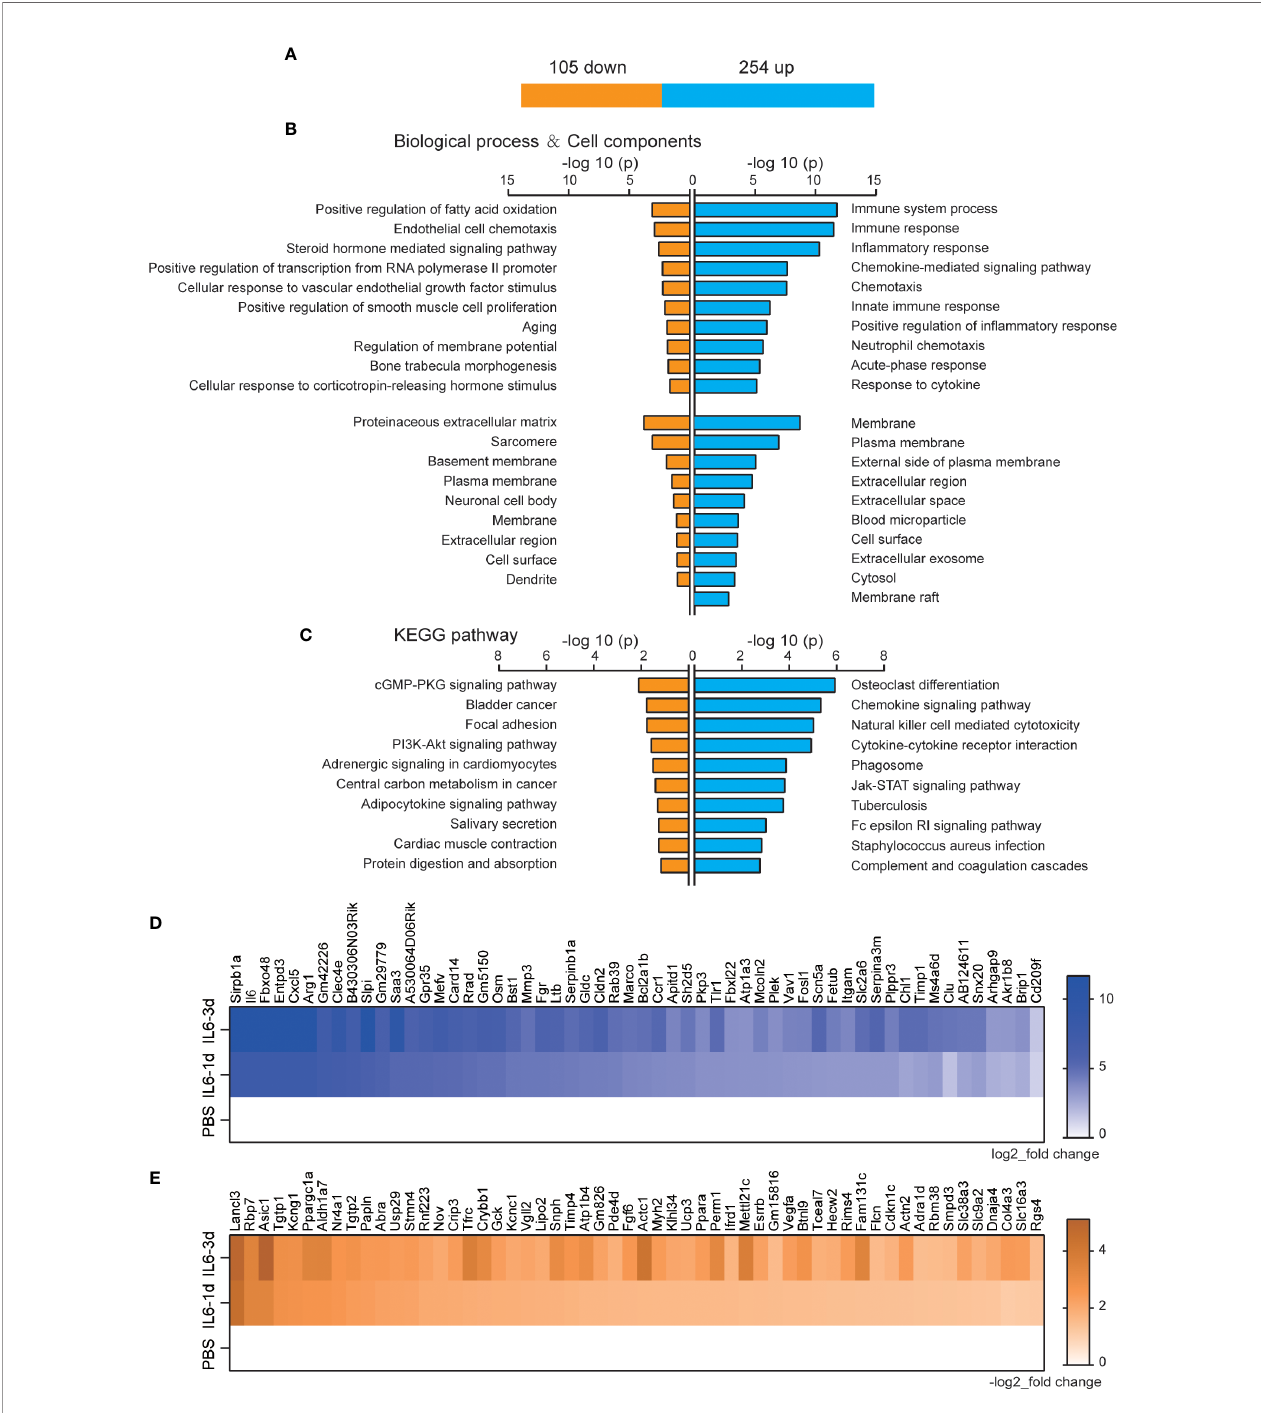
FIGURE 3 | Permanently changed genes and their biological functions after one and three days of interleukin-6 (IL-6) infusion. (A) The number of genes that were changed after both one and three days of infusion. Blue indicates up-regulated genes, and orange indicates down-regulated genes. (B) The biological process of up-regulated and down-regulated differentially expressed genes (DEGs) and the Gene Ontology (GO) analysis results of the cell components. Either the top 10 or all signi fi cant GO terms are displayed. (C) The Kyoto Encyclopedia of Genes and Genomes pathway analysis results of the up-regulated and down-regulated DEGs. The top 10 GO terms are displayed. (D) Heat map of up-regulated DEGs with an increase in upregulation folds. (E) Heat map of down-regulated DEGs with an increase in downregulation folds. For (D, E) , data were normalized to PBS controls. KEGG, Kyoto Encyclopedia of Genes and Genomes; PBS, phosphate-buffered saline; down, down-regulated; up,